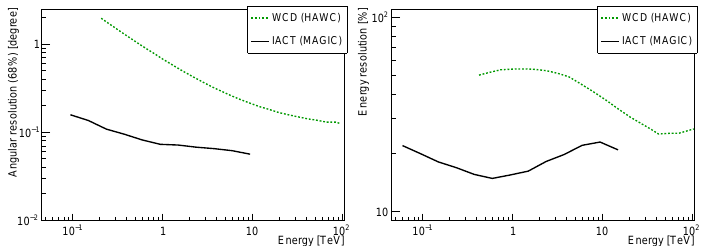
Figure 3. Comparison of the angular (left panel) and energy (right panel) resolution of a WCD (HAWC, dotted green line) and an IACT (MAGIC, using look-up table energy estimations, solid black line). HAWC angular resolution is taken from https://www.hawc-observatory.org/observatory/sensi.php (accessed on 19 November 2021), and energy resolution (for neural networks analysis, recalculated from log space to linear space) from [20]. MAGIC performance in both panels is taken from 10